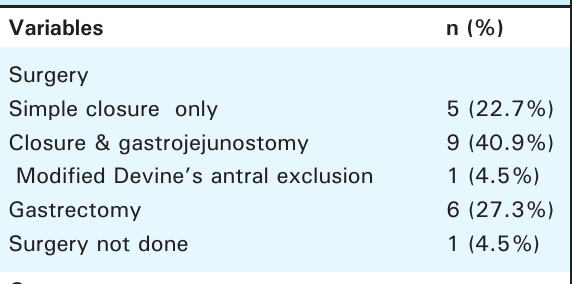
Table 2 . Surgical Procedures and